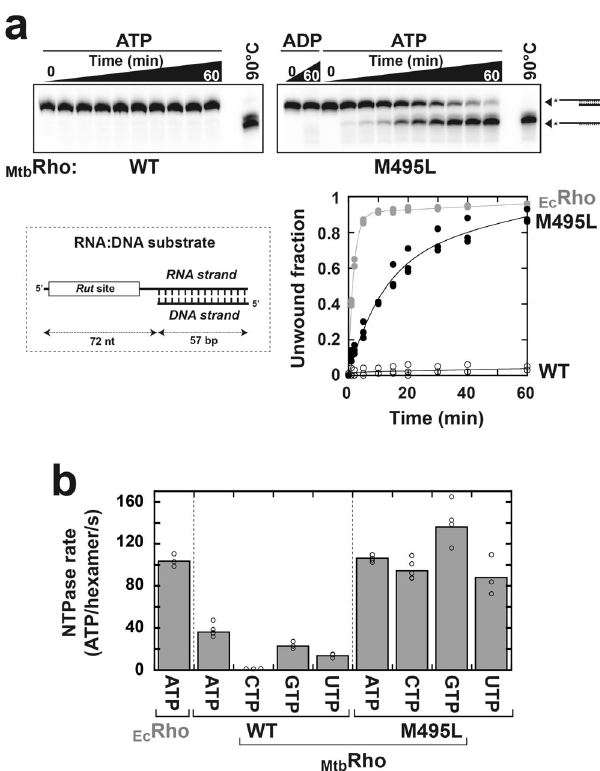
Fig. 4 The Met495 side-chain impairs the activity of the Mtb Rho motor. The M495L mutation stimulates the RNA-DNA duplex unwinding ( a ) and NTP hydrolysis ( b ) activities of Mtb Rho. A loss in NTP selectivity is observed for the M495L mutant as compared to WT Mtb Rho. Graph and histogram values were deduced from n = 3 independent experiments except for ATPase with M495L ( n = 4), ATPase with WT Mtb Rho ( n = 5), and CTPase and GTPase with M495L ( n = 5). Bars in panel b correspond to mean